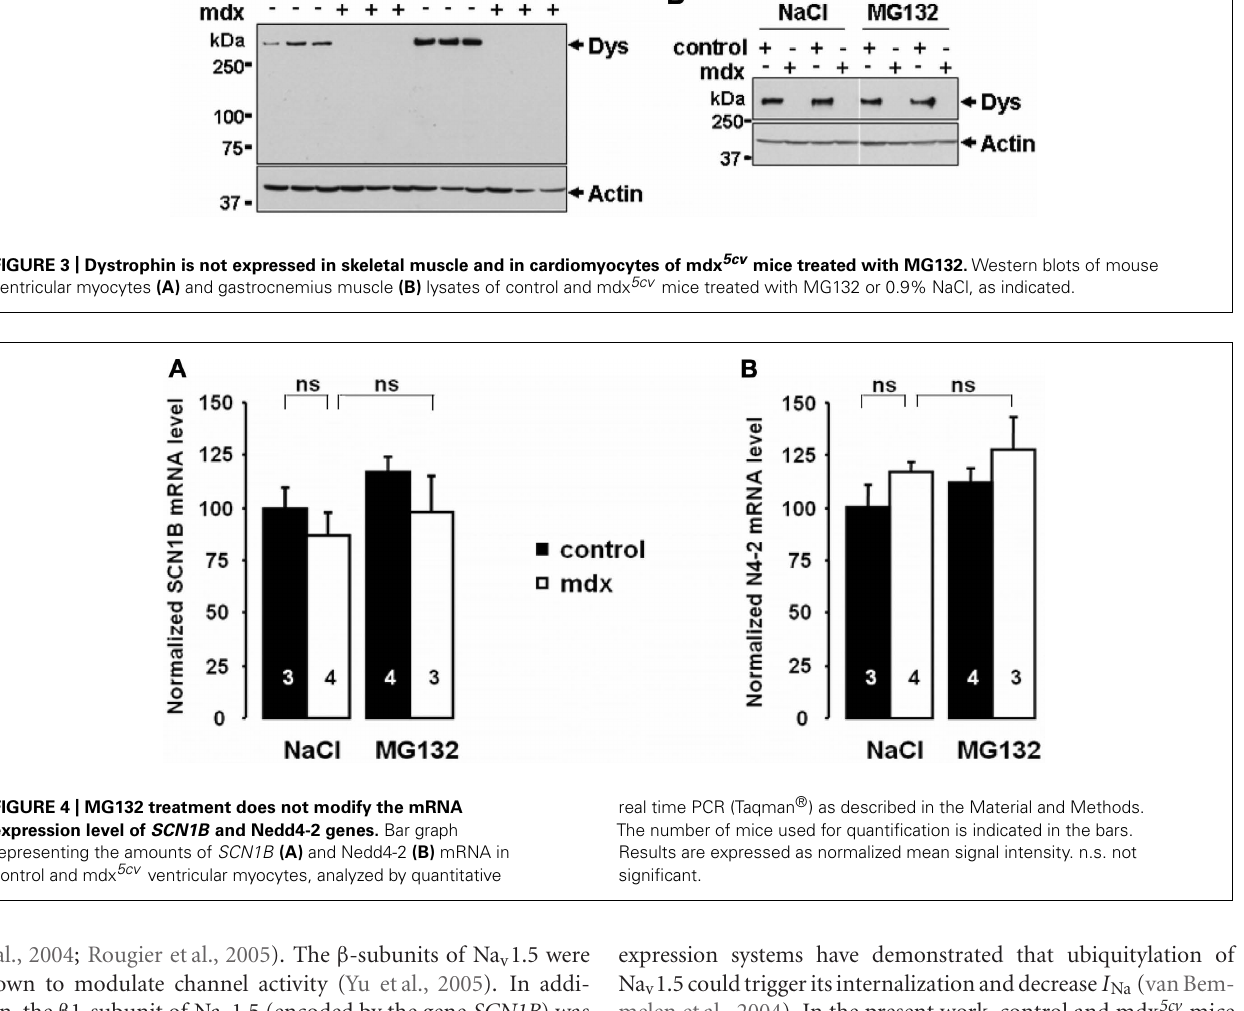
FIGURE 4 | MG132 treatment does not modify the mRNA expression level of SCN1B and Nedd4-2 genes. Bar graph representing the amounts of SCN1B (A) and Nedd4-2 (B) mRNA in control and mdx 5cv ventricular myocytes, analyzed by quantitative